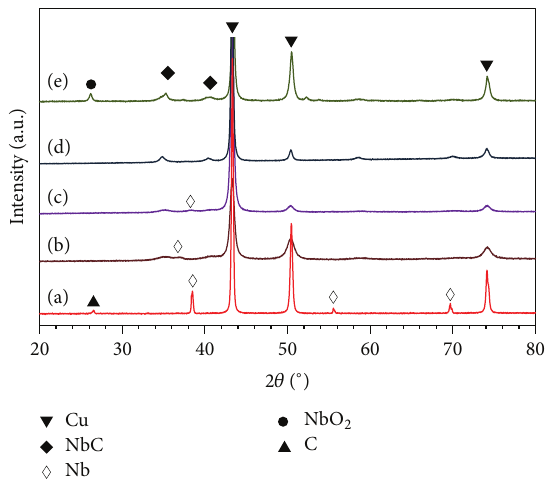
Figure 3: XRD patterns of (a) mixture of Cu-Nb-C powder, (b) the as-milled Cu-15vol%NbC powder after 30h milling, (c) the as- HPTed Cu-15vol%NbC compact after 20 min of HPT deformation, (d) the as-HPTed Cu-15vol%NbC after annealing, and (e) the as- milled Cu-15vol%NbC compact after